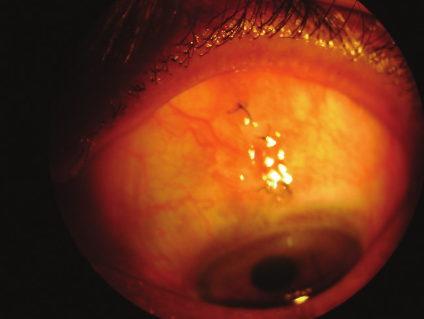
Figure 4: Post-operative appearance of first case after the bleb excision with conjunctival auto